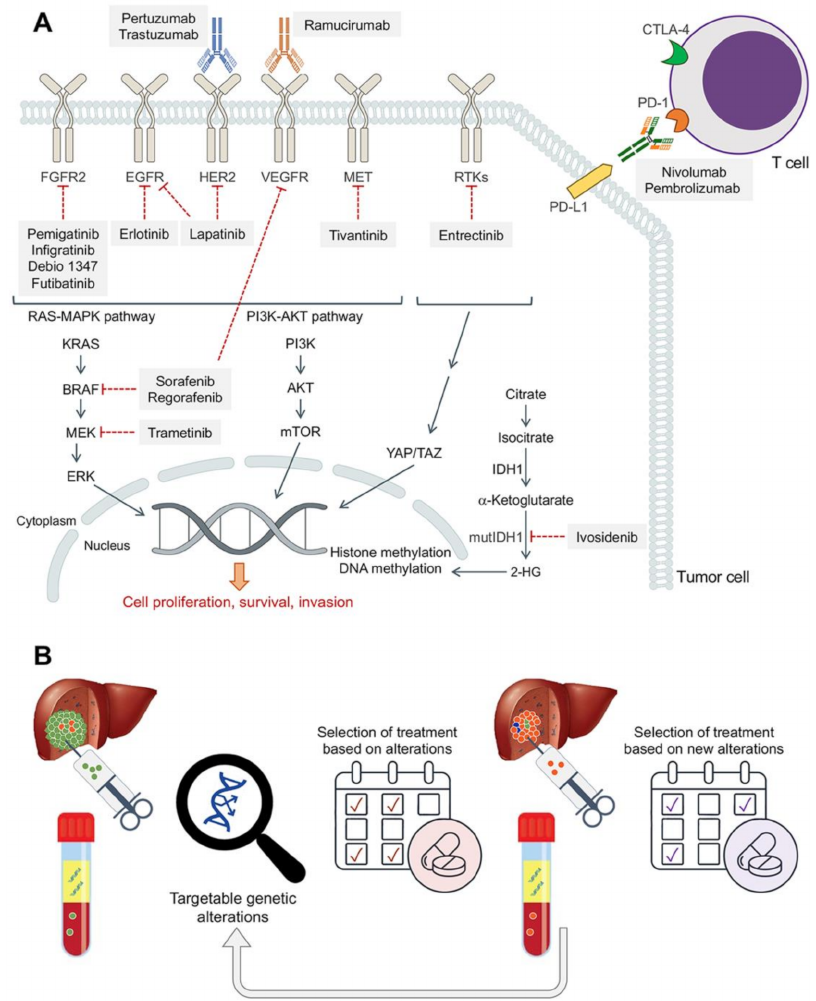
Figure 2. ( A ) Schematic representation of targeted therapies and immunotherapies that are being investigated in patients with CCA and are in more advanced studies. Resistance mechanisms have been described for some of them as has been discussed. ( B ) Schematic representation of the types of patient samples that can be used for molecular profiling to select the best targeted therapy for each patient at different